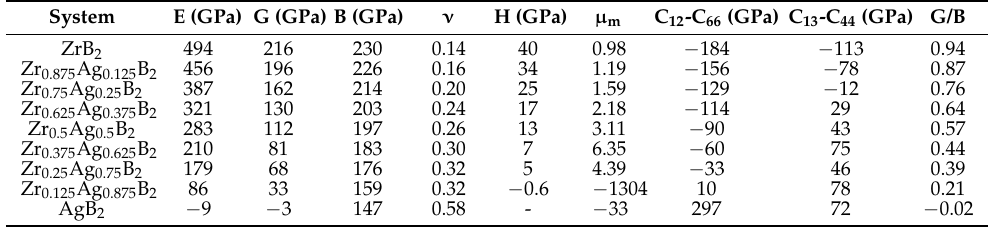
Table 1. Computed elastic properties of ZrB 2 and Zr 1 − x Ag x B 2 solid solutions with respect to Ag con- tent (x). Speci fi cally, E,G,B, ν , and H denote the elastic modulus, shear modulus, bulk modulus, Poisson’s ratio, and Vickers hardness, respectively, while B/C 44 is the machinability index, C 12 -C 66 and C 13 -C 44 are directional Cauchy pressures in the hexagonal (0001) and (10-10) directions and G/B denotes Pugh’s ratio.